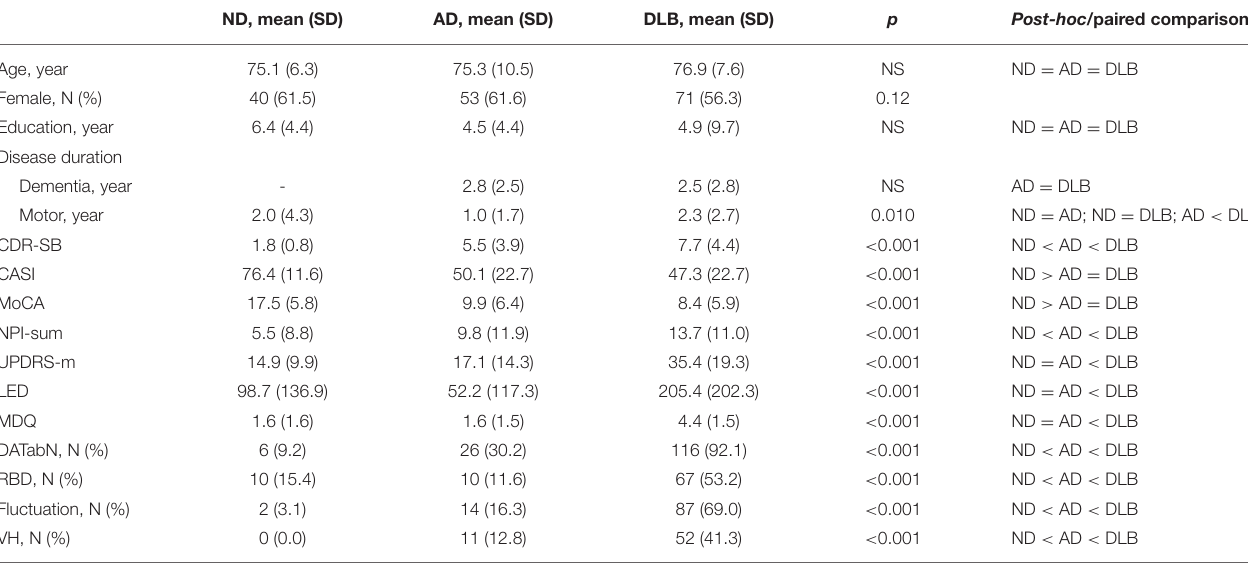
TABLE 1 | Comparison of demographic data among the ND ( N = 65), AD ( N = 86), and DLB ( N = 126)